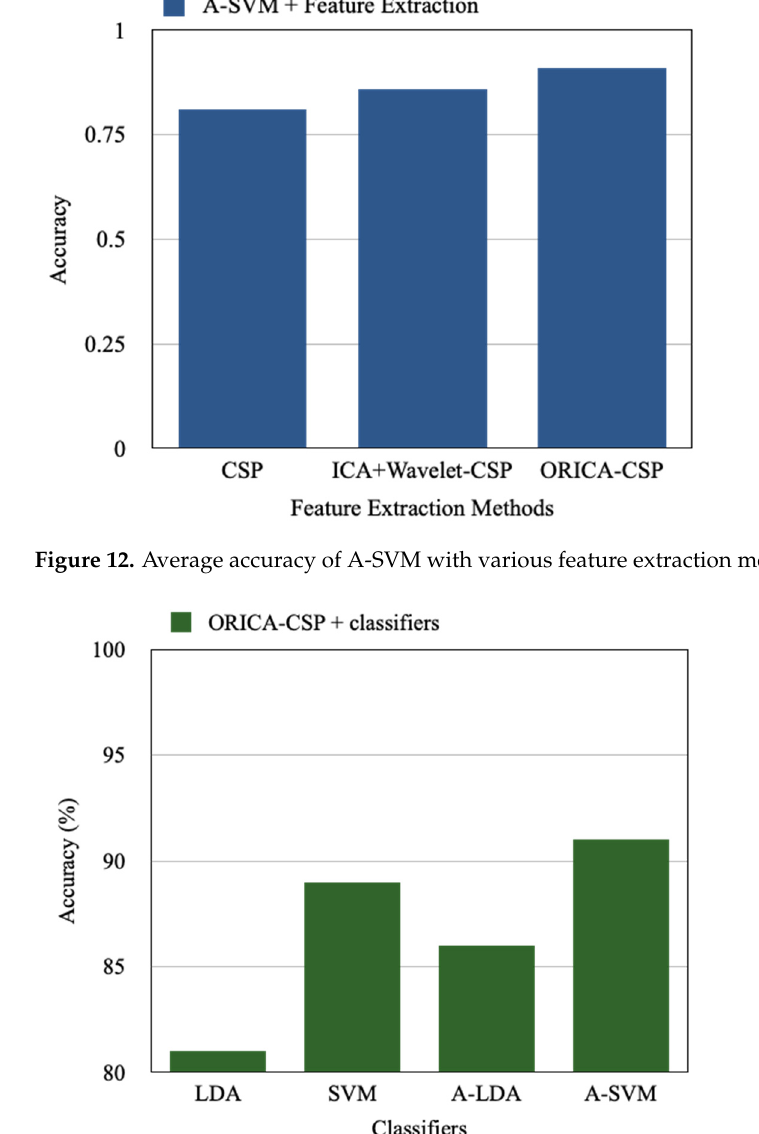
15 of 18 Figure 11. Classifier comparison chart with different feature extraction methods. Table 5. The average classification accuracy of several feature extraction techniques is compared.